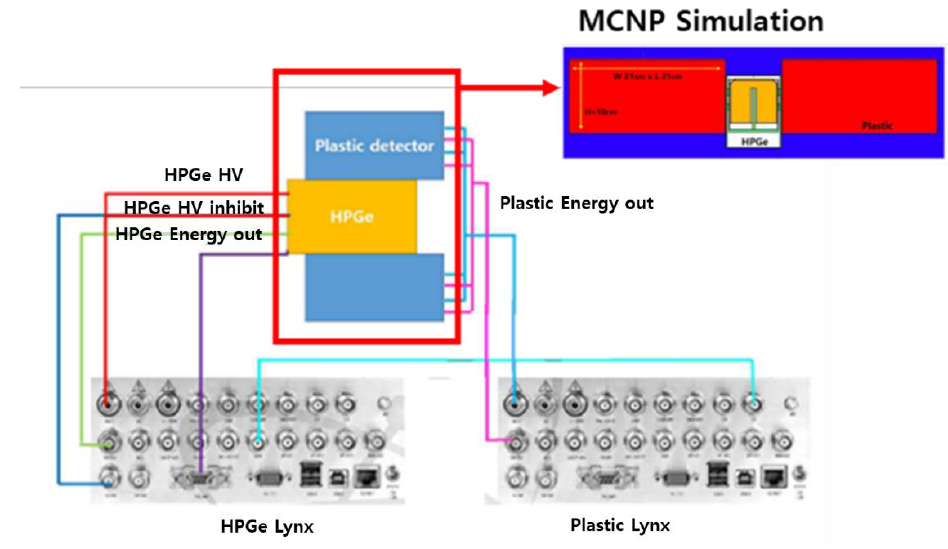
Figure 13. Configuration diagram of Compton suppression system circuit processing device [40].